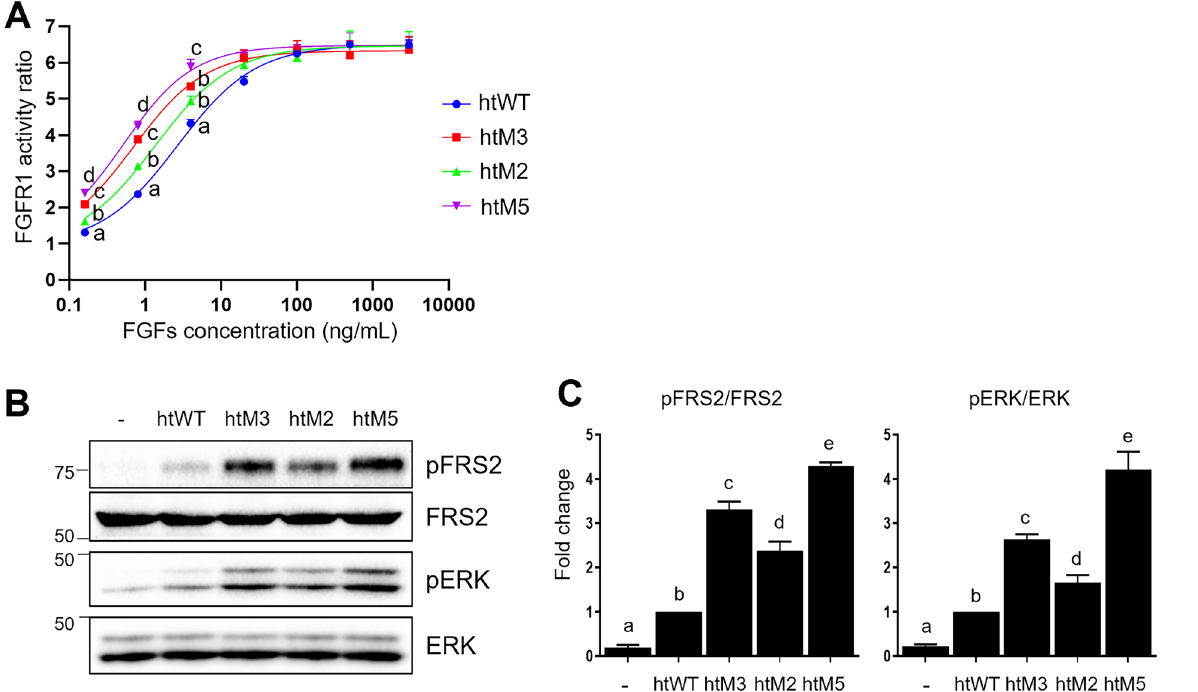
Figure 6. Cell-based activity tests of htM2, htM3, and htM5. ( A ) Modified HEK293 cells used for reporting FGFR1c/β-Klotho activity was treated with the wild type htFGF21 (htWT), htM2, htM3, and htM5 at the indicated concentration for 6 h. Cell lysates were prepared for detection of luciferase activity. The levels of FGFR1c/β-Klotho activity in non-treated cells were set to 1, and the other values were calculated relative to